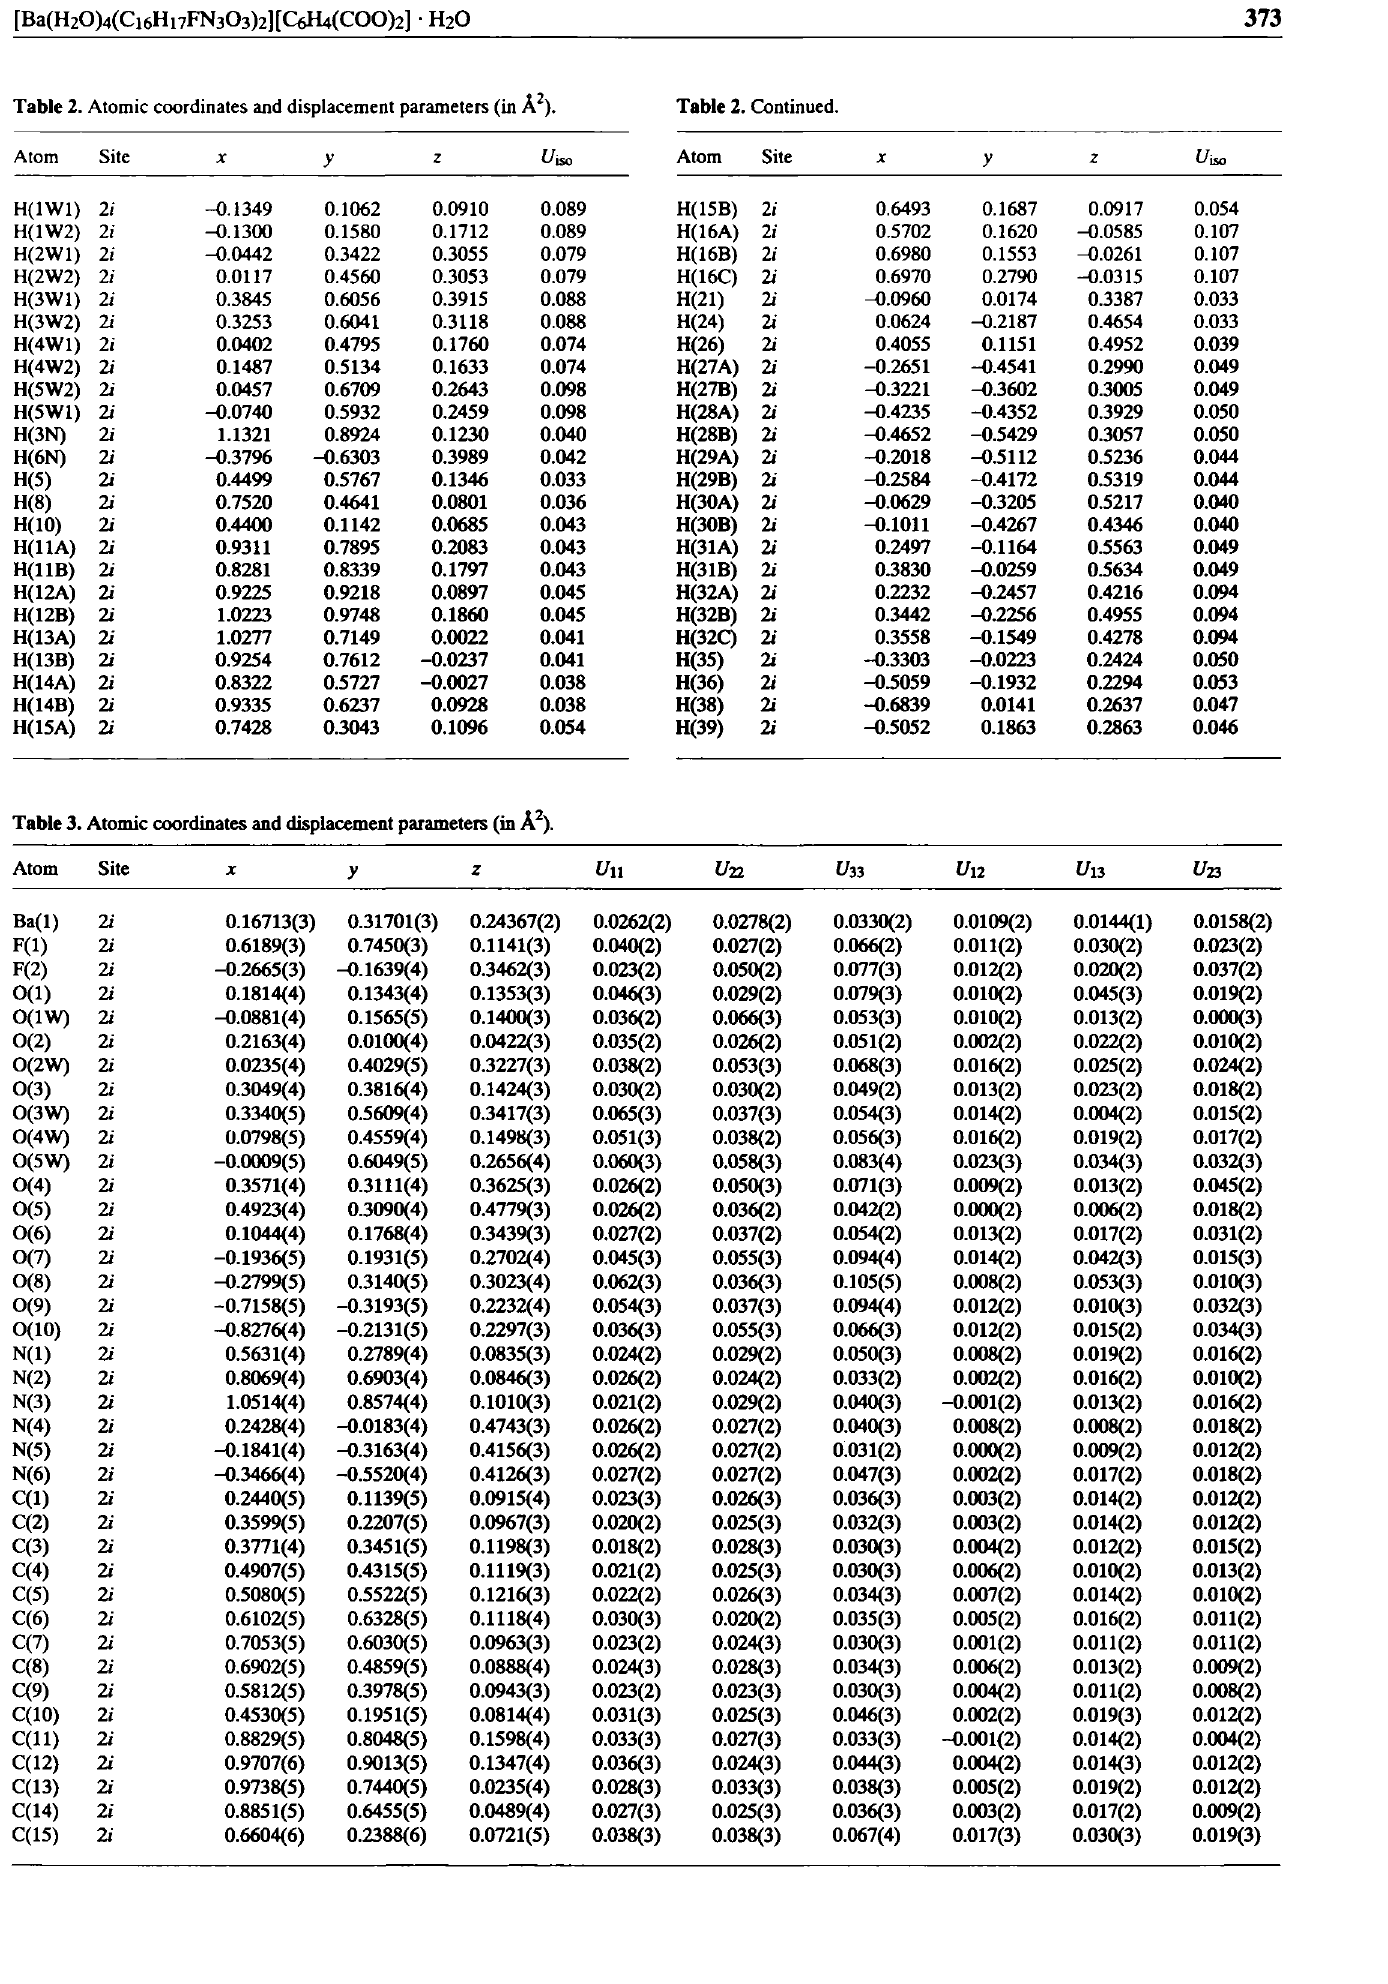
Table 2. Atomic coordinates and displacement parameters (in Ä 2 ). Table 2. Continued.